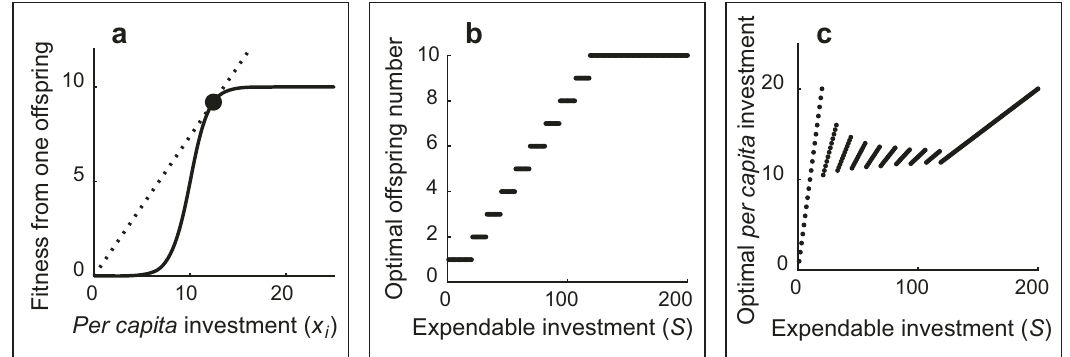
Fig. 2 Results of the model M1 (fully presented in Fig. S1a – d) where all offspring fi tness functions are identical. a The fi tness function in model M1 : the relationship between per capita investment in one offspring ( x i ) and the fi tness of this offspring. The most ef fi cient point, where f ð x Þ = x is the greatest, is marked with a black circle. b The relationship between the amount of expendable investment ( S ) and the optimal number of offspring (optimal brood size) receiving care from parents that maximize the total brood fi tness. c The relationship between the amount of expendable investment ( S ) and per capita investment ( x i ) for optimal brood size (shown in b ). The results of b , c are con fi rmed by mathematical analysis.